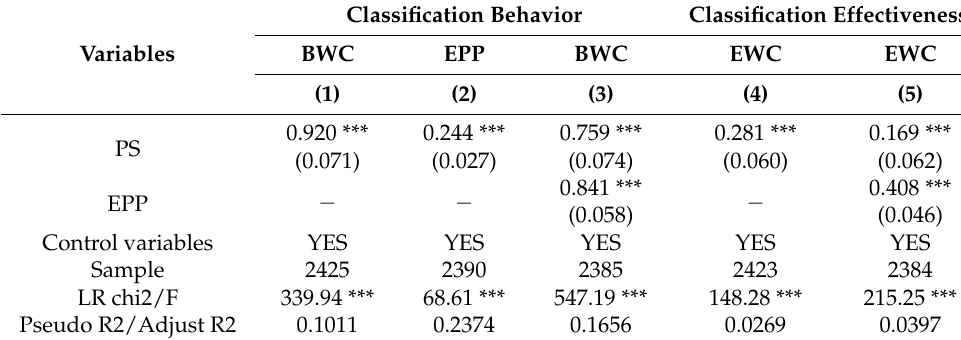
Table 8. Intermediary effect of environmental protection